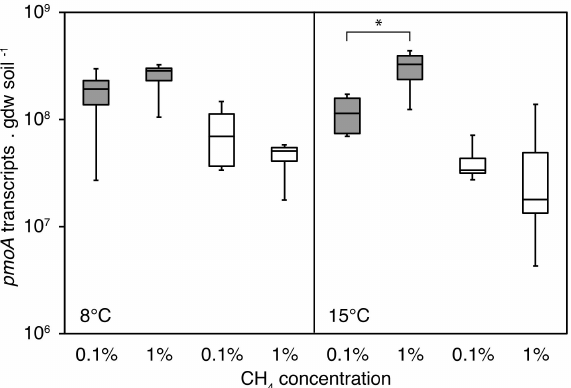
Figure 4. MOB pmoA transcript number after the three-week incubation at 0.1% and 1% CH 4 in grazed (gray) and exclosed sites (white). The left panel shows microcosms incubated at 8 ◦ C and the right panel shows microcosms incubated at 15 ◦ C. The y-axis shows pmoA transcript numbers per gram dry soil, log-transformed. Pairwise comparison using linear mixed models with peat blocks as random variables shows significant differences in the pmoA transcripts (* p =